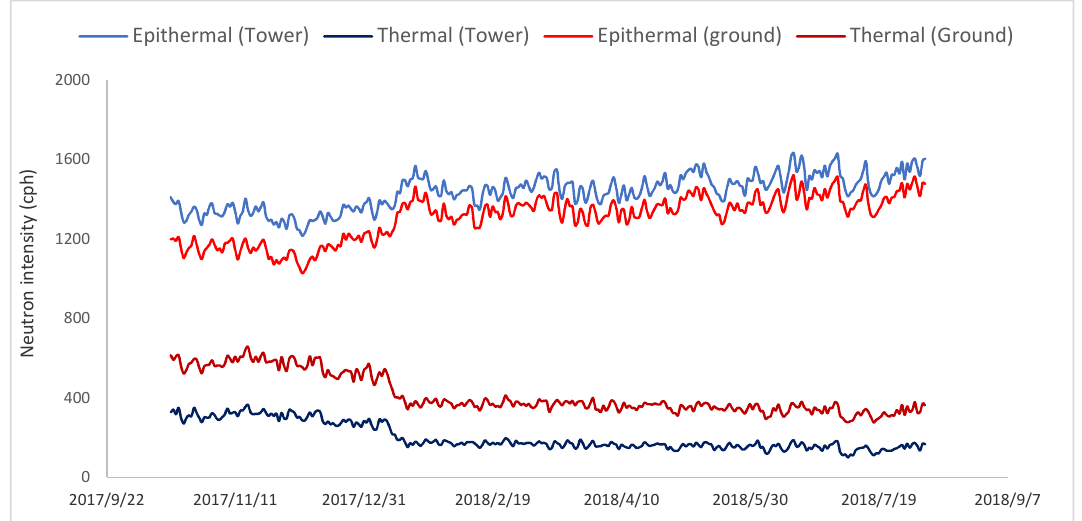
Figure 6. Epithermal and thermal neutron intensities for the tower CRNS at 18 m and ground CRNS at 2 m from October 2017 to August 2018 in the Two-Streams Catchment.